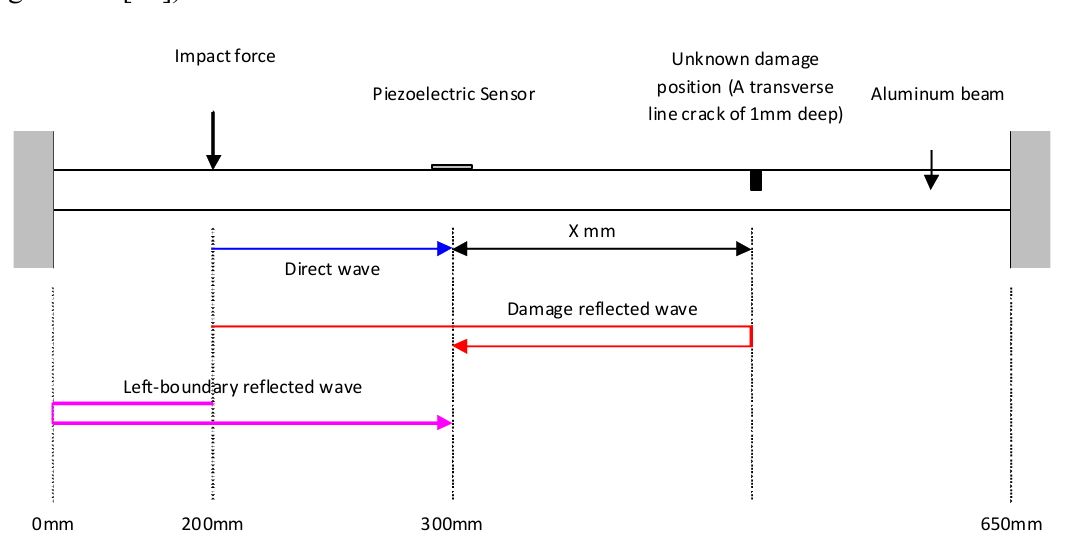
Figure 3. Experimental set-up to detect the transverse line crack in beam (adopted from Figure 6 in